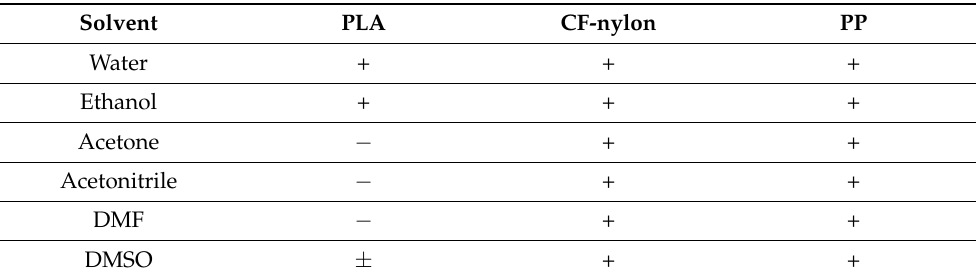
Table 1. Analysis of the stability of FFF parts made of various materials in organic and inorganic liquid media *.